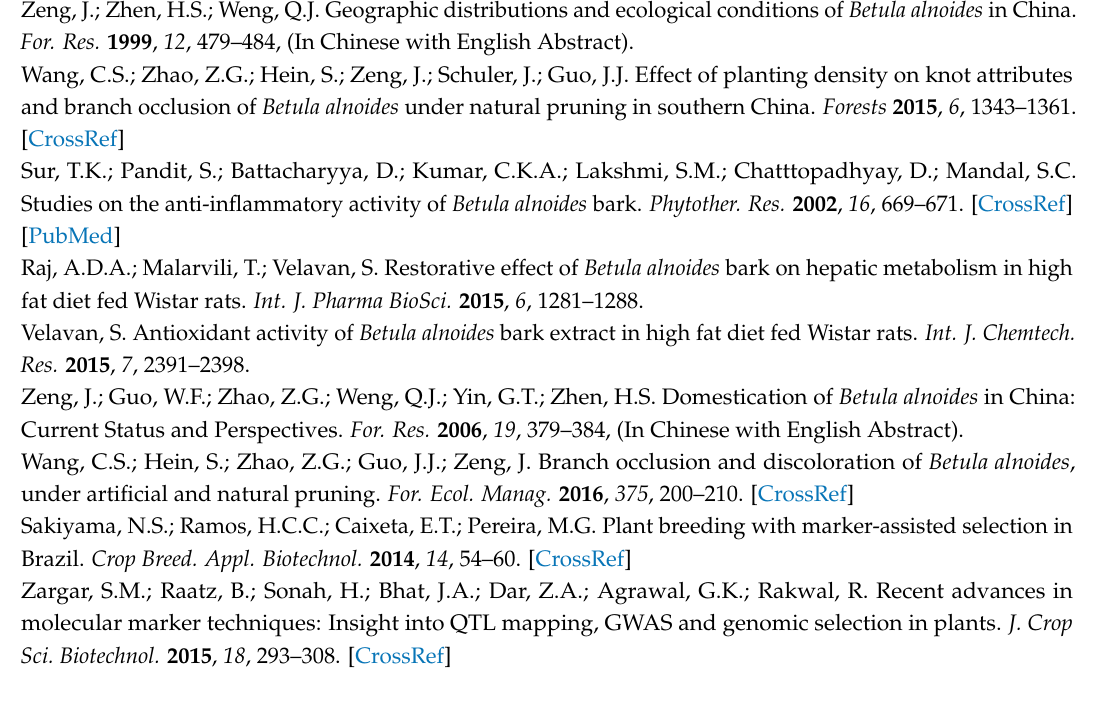
Supplementary Materials: The supplementary materials are available online. Table S1: 310 polymorphic SSR markers validated in 24 samples of Betula alnoides . Table S2: The PCR results for 270 SSR primer pairs in 24 samples of Betula alnoides . Table S3: Validation of 19 SSR markers developed previously in 24 samples of Betula alnoides . Table S4: Amplification rate of 96 SSR markers for Betula alnoides in six related species of genus Betula